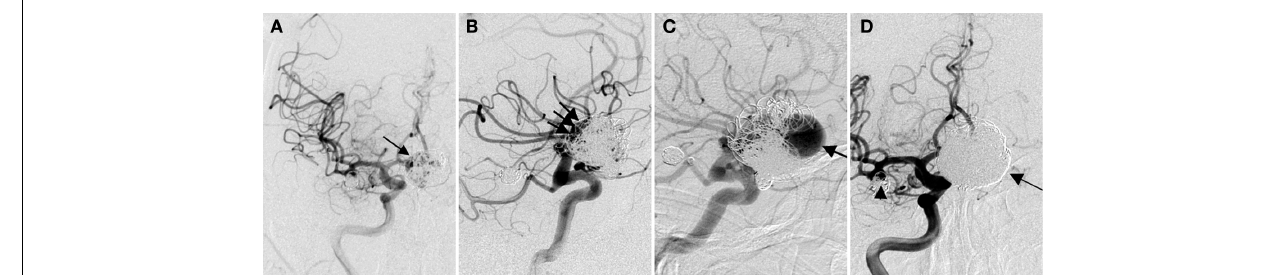
performed 6months after the patient made a good neurological recovery. (C) Lateral view of the right ICA injection shows significant recanalization of the dome of the aneurysm (arrow). (D) The patient underwent retreatment of the aneurysm with stent placement from the A1 segment of the right ACA into the A2 segment of the left ACA.This was followed by additional coil placement including gel coated coils. Subtracted view of the right ICA injection shows a dense coil mass in the giant aneurysm (arrow). Also note some recanalization of the right MCA aneurysm neck